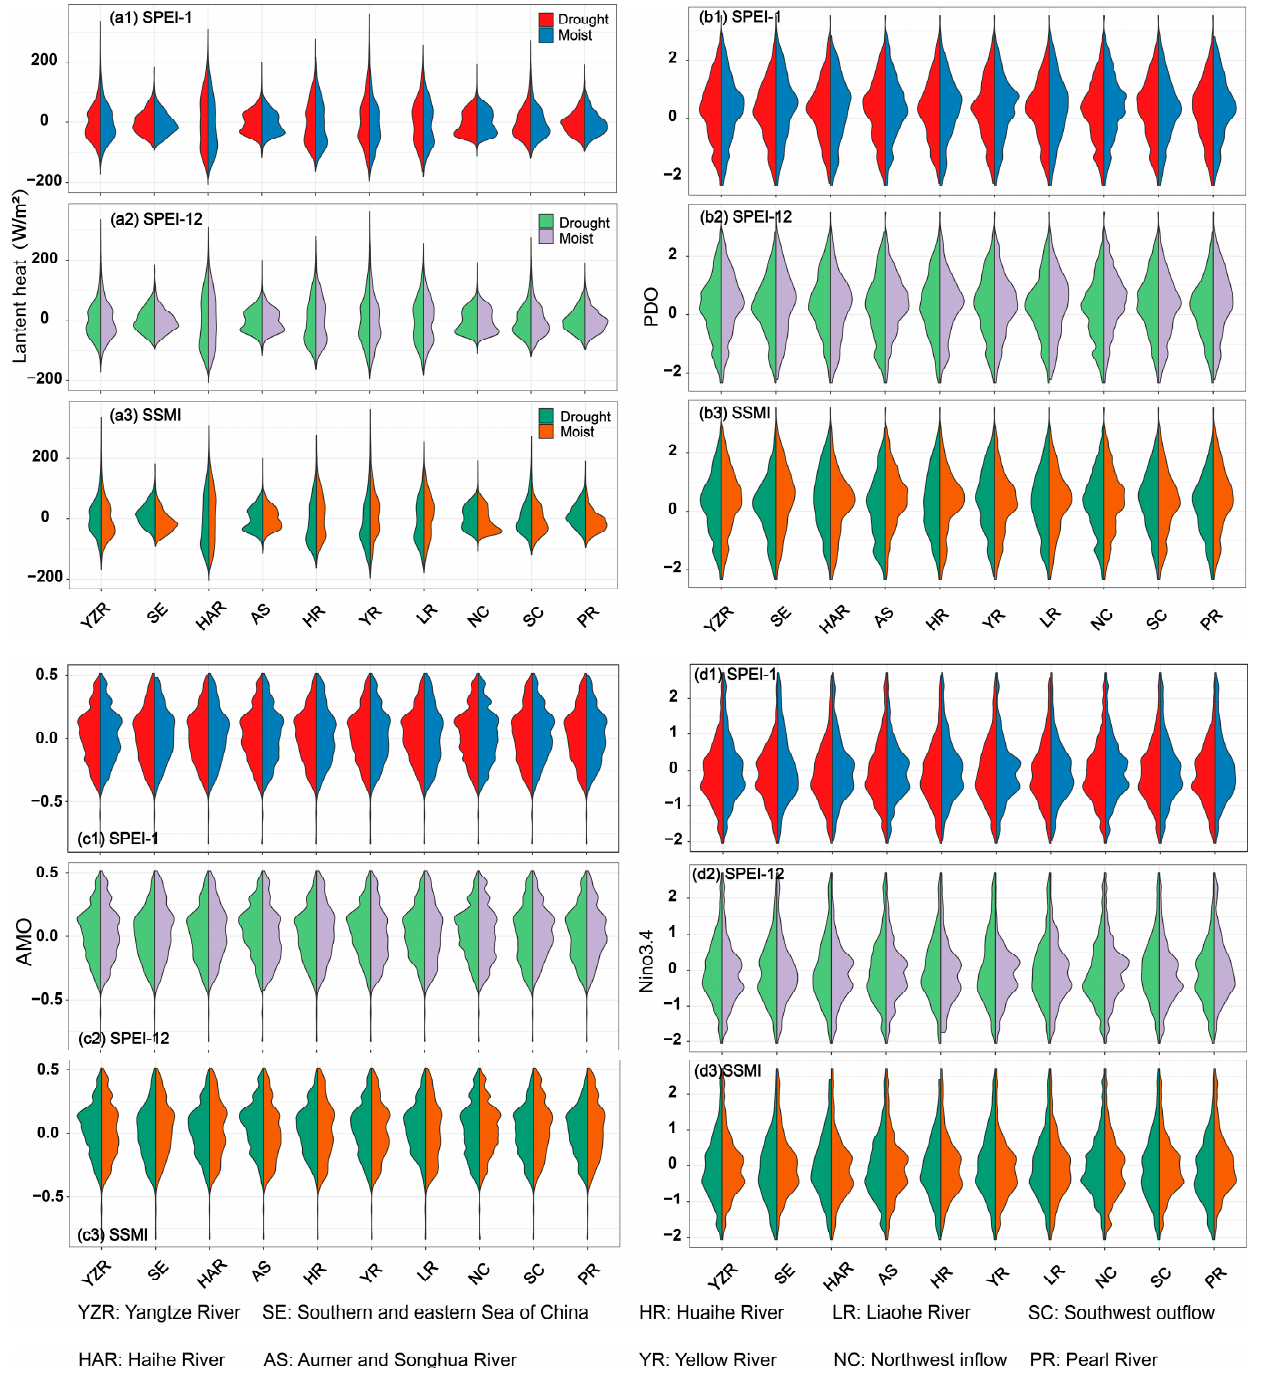
Figure 4. Response of LHF, PDO, AMO and Nino3.4 to the dry and non-drought months of in the major watersheds of China.